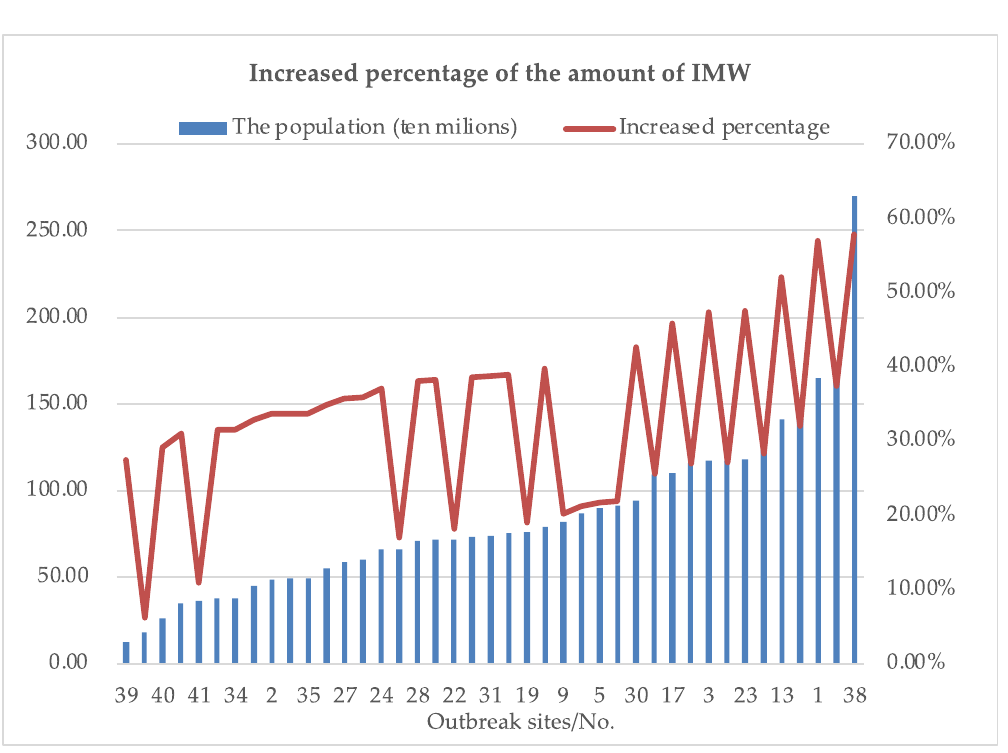
Figure 10. Effects of different outbreak sites (sorted according to population) on the amount of IMW.